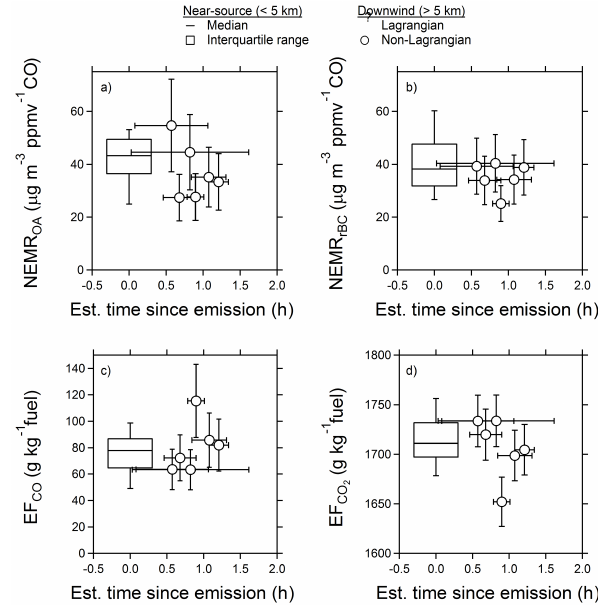
Figure 2. Near-source and downwind data collected during the FJ 9b prescribed fire. (a) The ratio of excess OA to CO; (b) the ra- tio of excess rBC to CO; c) emission or export factor for CO; and (d) emission or export factor of CO 2 . Near-source data are represented by box-and-whisker plots (boxes: 25th and 75th per- centiles; whiskers: 10th and 90th percentiles; horizontal lines: me- dian), while downwind data are represented by markers. Error bars associated with the markers indicate range of estimated time since emission ( x direction) and measurement uncertainty ( y direction). Error bars in x direction do not account for estimated 30% accuracy of wind speed.